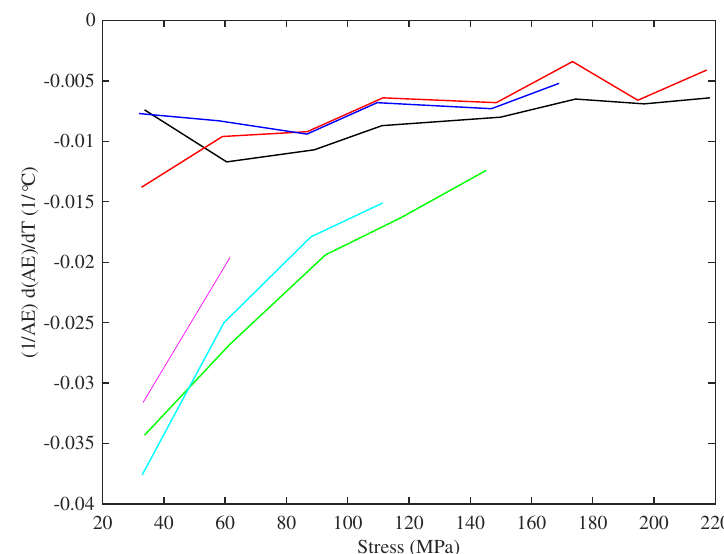
Figure 21. ( 1/ A 0 E 0 ) d ( AE ) / dT plotted against the applied stress. Colours identify the di ff erent tested strings (Table 1): black (8:A6), red (14:A5), blue (5:A4), green (23a:A3), cyan (29:E3), magenta (10b:A2).